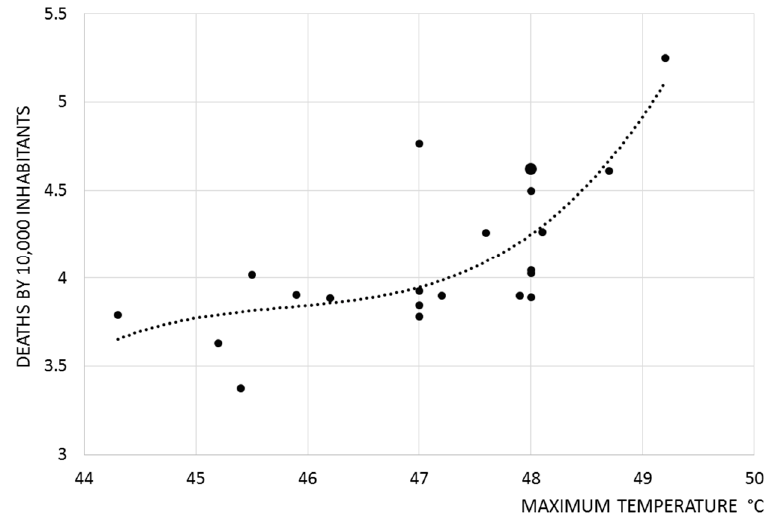
Figure 8. Mortality rate (per 10,000 inhabitants) versus maximum temperature during August in Mexicali (1990 to 2010).